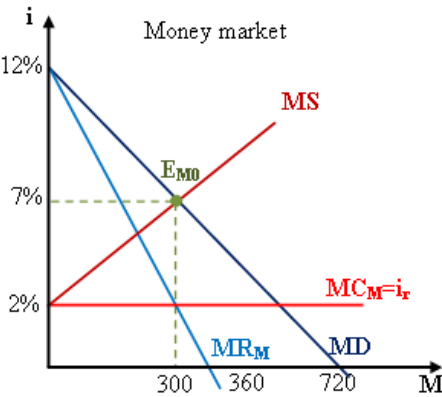
Figure 10. Money market equilibrium of the hypothetical economy.